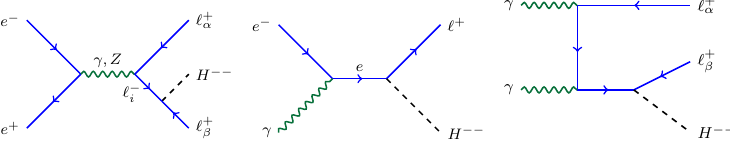
Figure 6. Representative Feynman diagrams for on-shell production of H ±± at future lepton colliders (cf. the processes in Equation (5)). Figure from Ref.